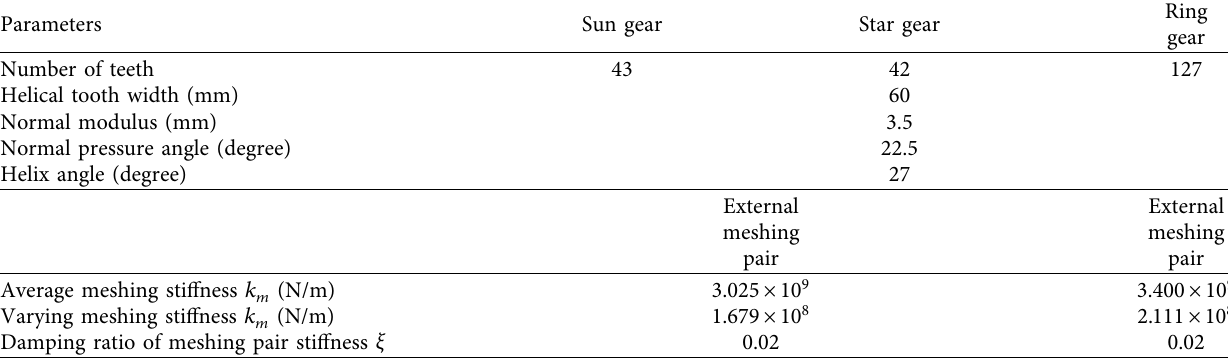
Table 1: GTF gearbox system parameters.